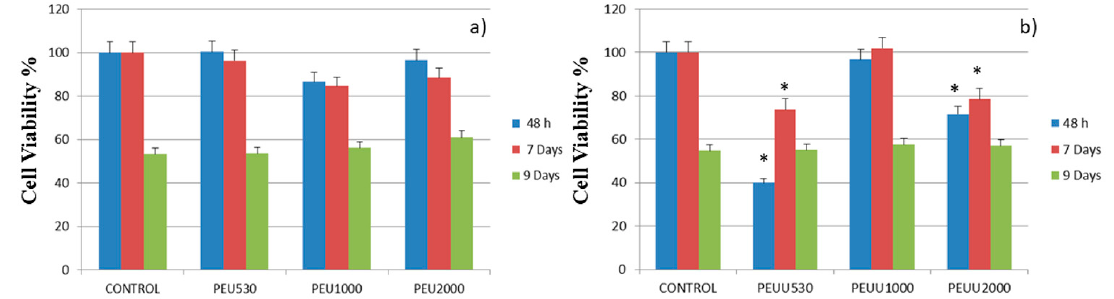
Figure 7. Alamar blue results for ( a ) PEUs and ( b ) PEUUs, using Hob from (INNOPROT, P10979), compared using a one-way ANOVA. * indicates statistical differences from the control p < 0.05.